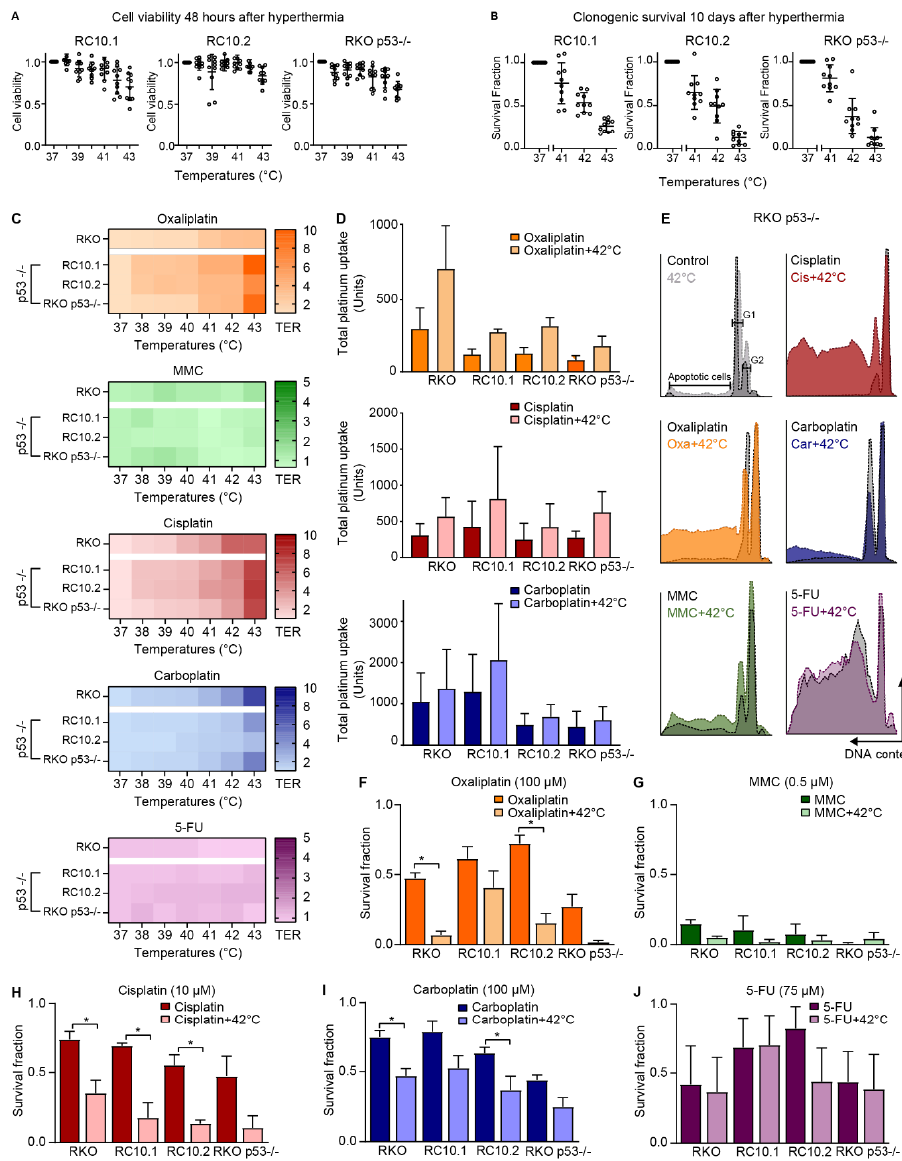
Figure 5. P53 status does not a ff ect the sensitivity of colorectal cancer (CRC) to hyperthermia. P53 protein function plays a central role in the arrest of the cell cycle in G1 phase after DNA damage. To study whether p53 status influences the sensitivity for HIPEC treatment, RC10.1, RC10.2, and RKO p53 − / − cells with a decrease of p53 levels and function were used. These cells were treated with hyperthermia alone to assess the cell viability ( A ) 48 h after treatment and clonogenicity ( B ) was assessed 10 days after treatment by clonogenic survival assays. For both experimental set ups, cells at 37 ◦ C represent the untreated controls. The mean of 10 independent experiments are presented. ( C ) Thermal Enhancement Ratio (TER) values obtained from cell viability assays are demonstrated by a color gradient: a darker color indicates higher TER values. The mean of 3 independent experiments are presented. ( D ) The cellular uptake of oxaliplatin, cisplatin, and carboplatin was assessed by measuring the platinum uptake using the CyTOF. Means ± standard error of the mean of 3 independent experiments are presented. ( E ) Representative flow charts of the Nicoletti assay to assess apoptotic levels and cell cycle distribution. Clonogenic survival assays were performed to assess long-term cell survival 10 days after treatment with oxaliplatin ( F ), MMC ( G ), cisplatin ( H ), carboplatin ( I ), and 5-FU ( J ). Means ± standard error of the mean of 4 independent experiments are presented. * p <